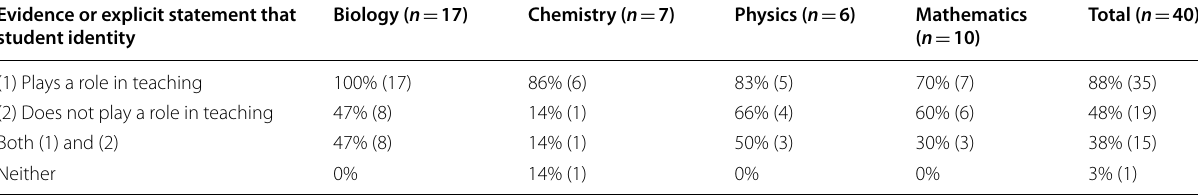
a These categories are not disjoint. Each instructor in “Both (1) and (2)” is also counted in (1) and (2)